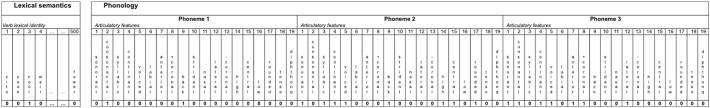
Coding scheme to encode each verb as a distributed pattern of activation over a set of units in the input of the artificial neural network. The training set comprised 500 artificial verbs, constructed using the phonology of English. A small number of consonant-vowel templates were used to build tri-phonemic verb stems. In addition to phonological input, lexical semantic information represented the identity of each verb. The output of the network was the phonological past tense form of each verb. The training set was built to capture the key structure of the English past tense system (Plunkett & Marchman, 1991). The coding scheme shows the lexical semantic input and phonological feature set for the verb ‘cool’ (/k/ /U/ /l/), with the regular past tense ‘cooled’.